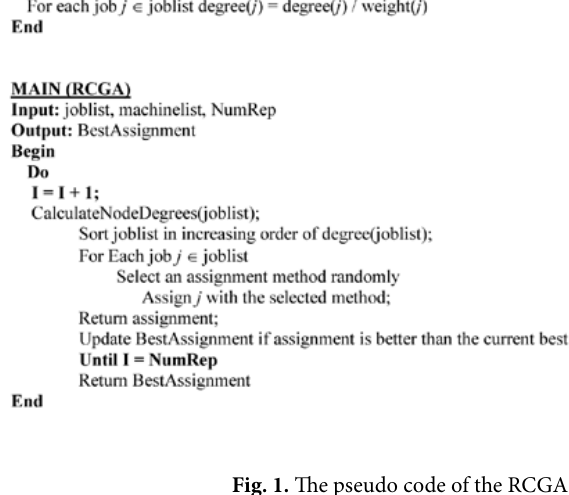
Fig. 1. The pseudo code of the RCGA